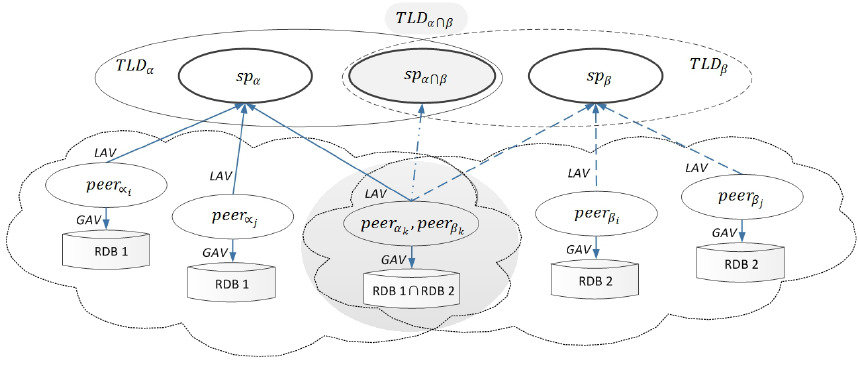
Figure 5. A data request uses its own data usage context to decide which super-peer to contact. Each super-peer binds a type of law for data access control in its SPD. For example, agent at the sp uses the data protection law in TLD α α security law in TLD . Finally, a query for data exchange, abode by agent β laws at the sp in TLD α ∩ β α ∩ β